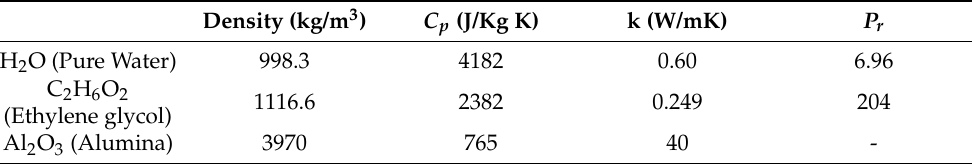
Figure 1. Physical description to mathematical model. Table 3. Thermophysical characteristics of